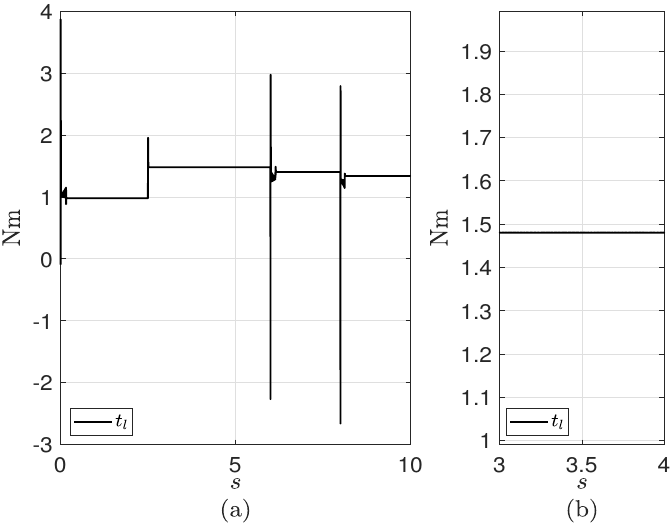
Figure 19. ( a ) Electromagnetic torque t e . ( b ) Electromagnetic torque during steady state